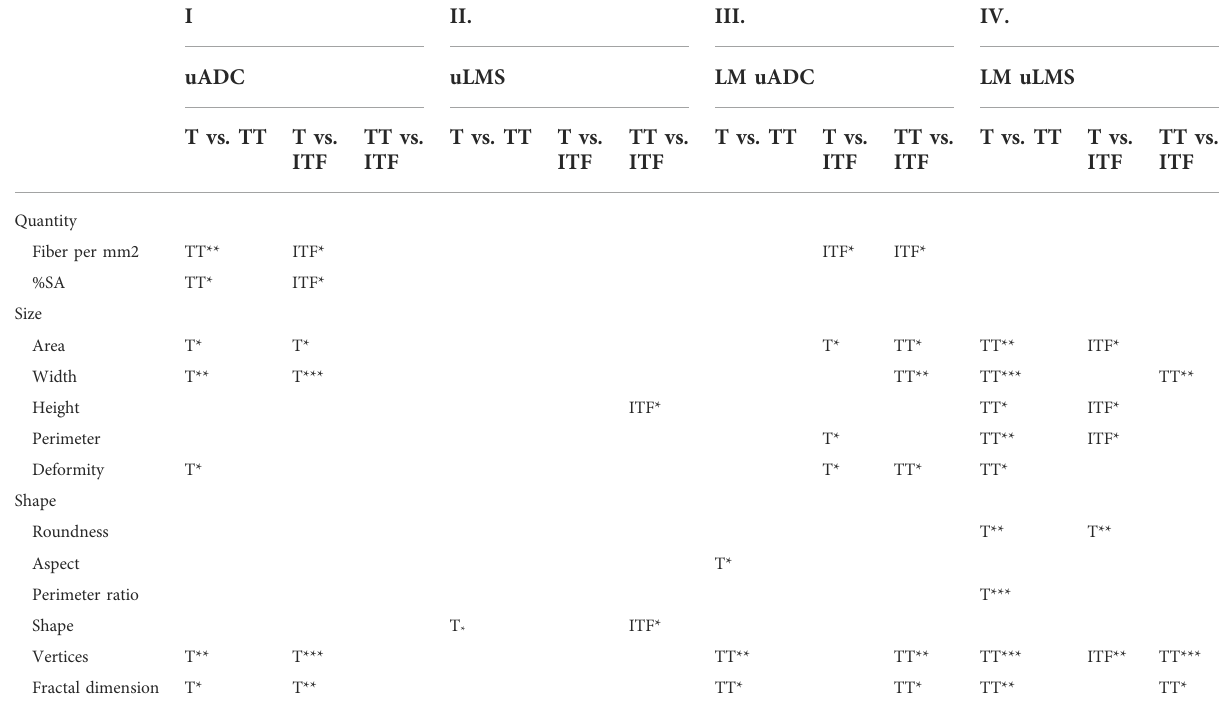
TABLE 1 Comparison of histomorphometric characteristics of reticulin fi bers between each tumor area in 1 × 1 mm